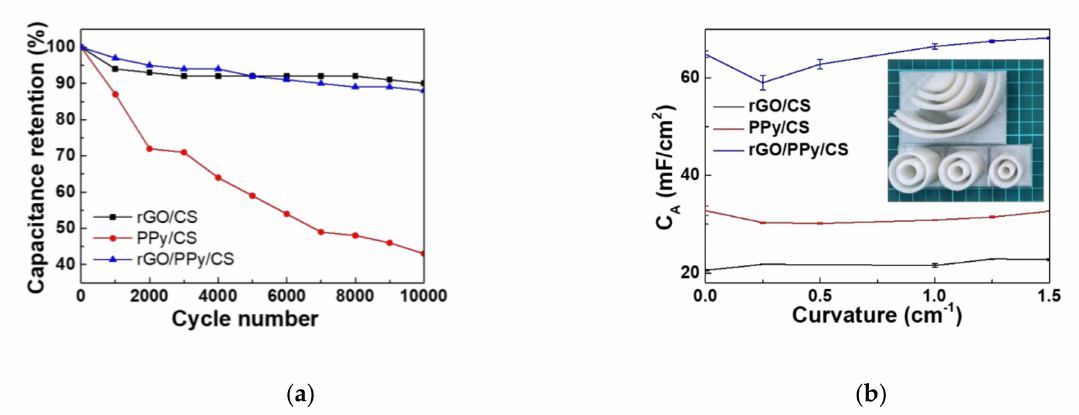
Figure 9. ( a ) Cycling stability test with a potential scan rate of 200 mV/s. ( b ) Bending test under different curvatures with the discharging current of 1